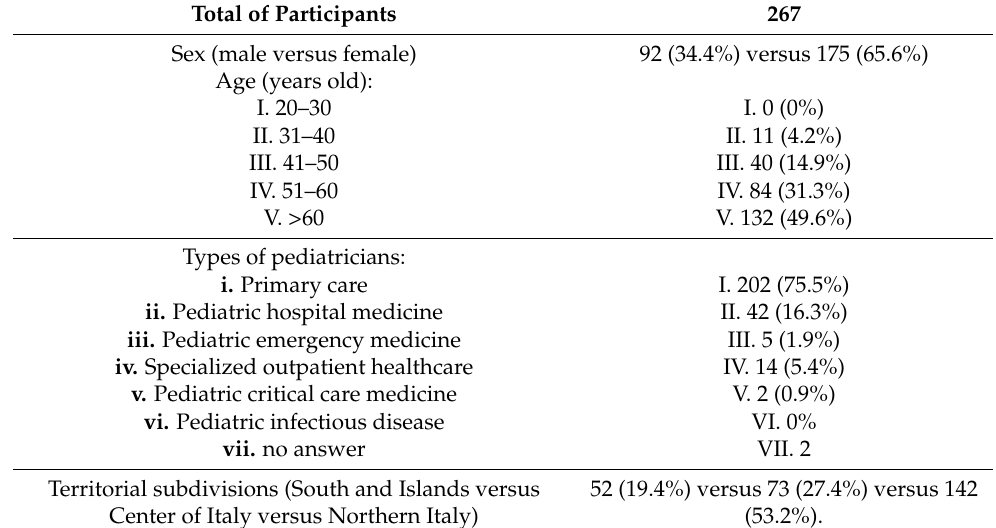
Table 2. Survey participants’